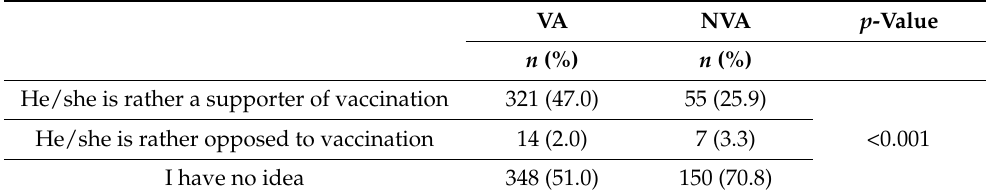
Table 8. Coaches’ attitudes toward COVID-19 vaccination among athletes vaccinated (VA, n = 683) and unvaccinated (NVA, n = 212) against